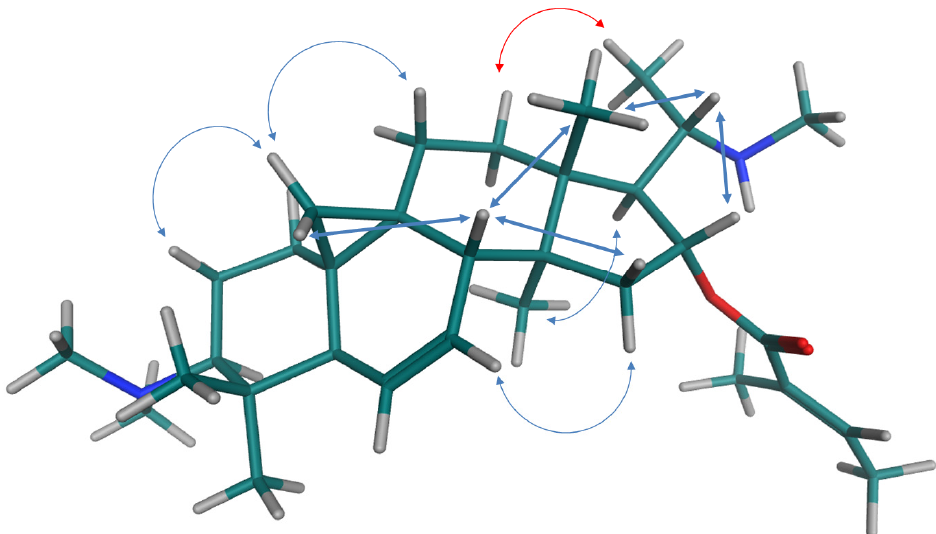
Figure 4. Main NOEs observed in a 2D-NOESY spectrum of O -tigloylcyclovirobuxeine-B ( 1 ). The molecular model represents the lowest energy conformer found in a conformational